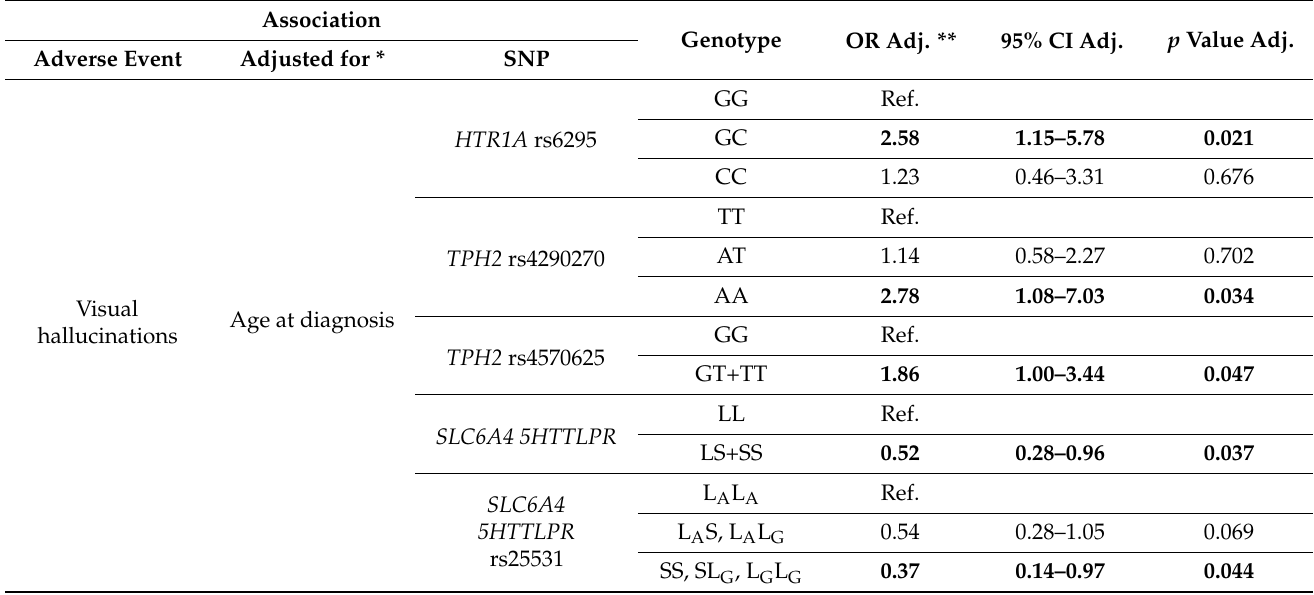
Table 2. Nominally significant associations adjusted for significant clinical parameters—multivariate